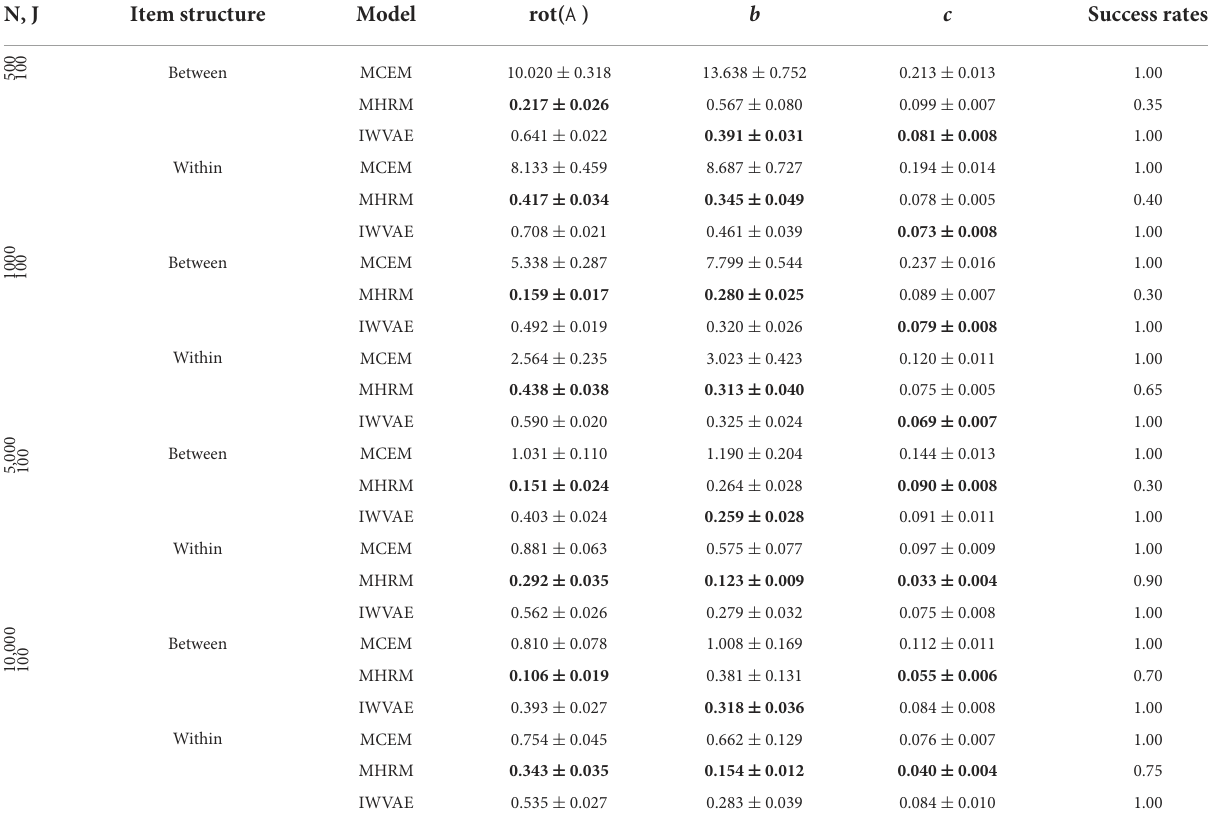
TABLE 3 Mean and SE of RMSE of M p estimate on M3PL models under single regime setting, best results are in bold. N, J Item structure Model c Success